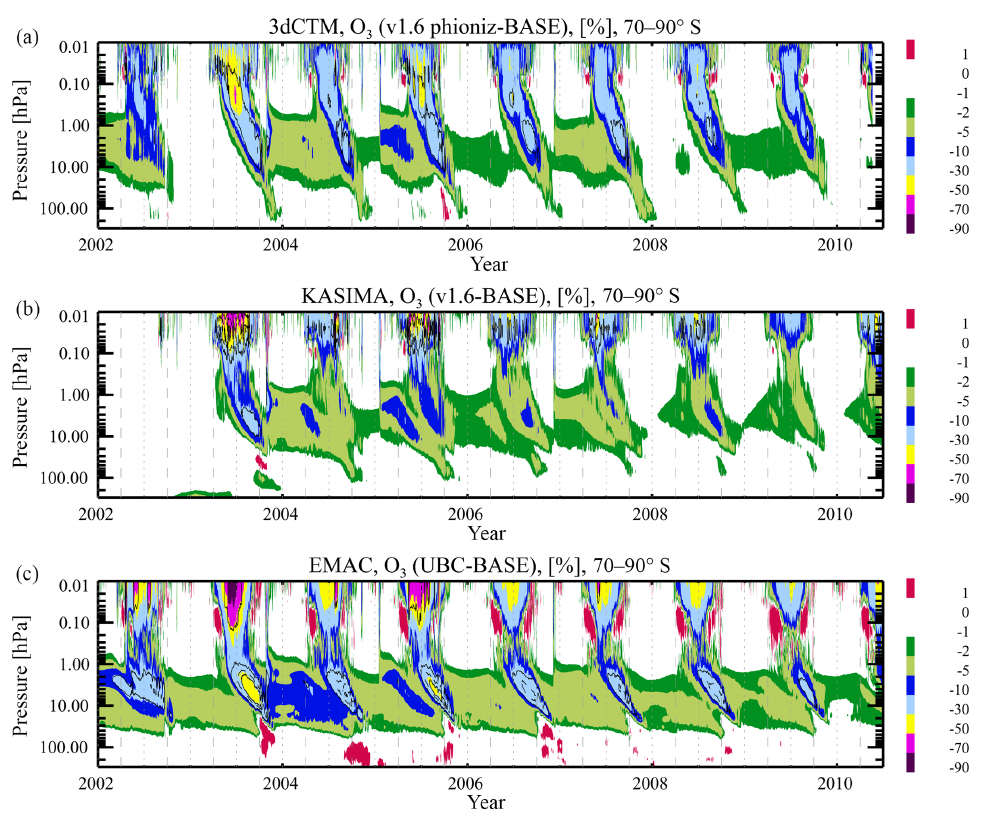
Figure 12. Relative ozone anomalies due to energetic particle precipitation at high southern latitudes (70–90 ◦ S), calculated as the difference of model runs with to without particle impact (%). (a) 3dCTM (v1.6 phioniz – Base), (b) KASIMA (v1.6 – Base), (c) EMAC (UBC – Base). The gray shaded area in the middle figure denotes the time period before the start of the KASIMA model runs. Dashed and dotted vertical gray lines mark zero, one-quarter, one-half, and three-quarters of each year. The thin black contours refer to − 1.5 (solid), − 1 (dashed) and − 0.5 (solid)